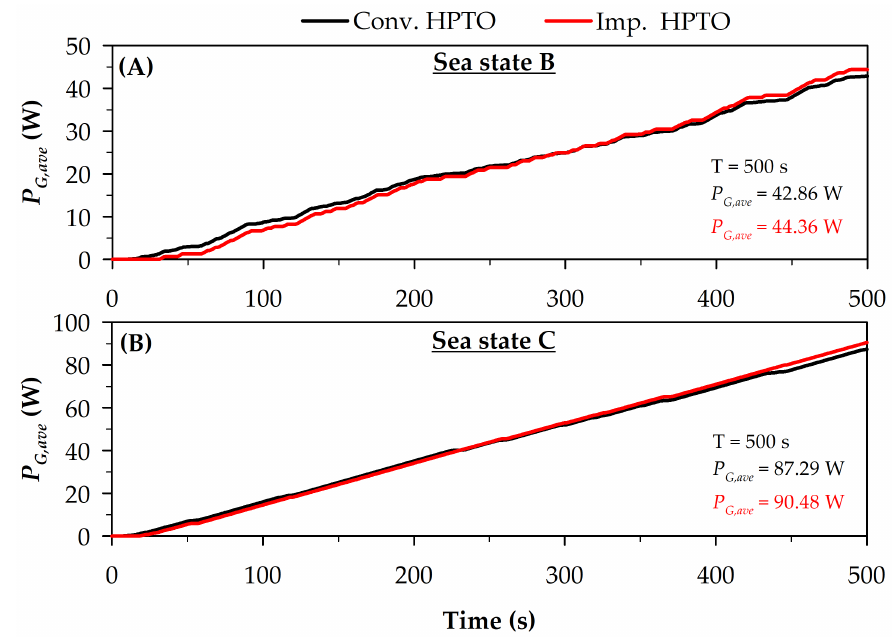
Figure 23. The average P G , conv . and P G , imp . for the different significant wave height cases.